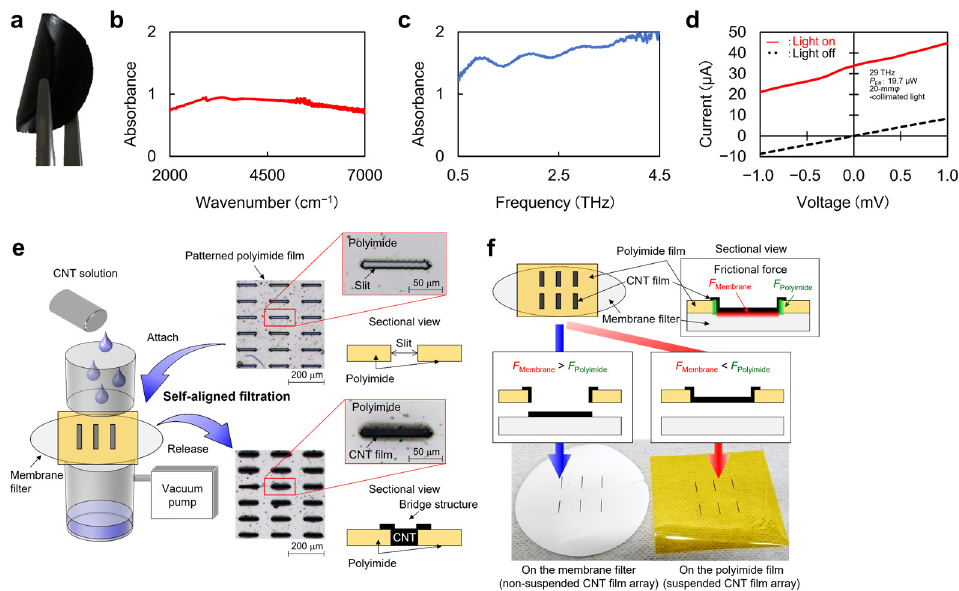
Figure 2. Fundamental properties of CNT films as the device material for the PTE sensors. ( a ) Photograph of a CNT film. ( b ) IR absorption characteristic of the CNT film. ( c ) THz absorption characteristic of the CNT film. ( d ) Current-voltage characteristics with and without light irradiation to the CNT film PTE sensor. ( e ) Diagram of the self-aligned CNT filtration process. ( f ) Examples of selective CNT film patterning. ( a , d ): Reproduced with permission from [24] Copyright 2021, the authors, published by Wiley-VCH. ( b ): Reproduced with permission from [26] Copyright 2022, the authors, published by American Association for the Advancement of Science. ( c ): Reproduced with permission from [25] Copyright 2021, the authors, published by Springer Nature. ( e , f ): Reproduced with permission from [36] Copyright 2021, the authors, published by Wiley-VCH.